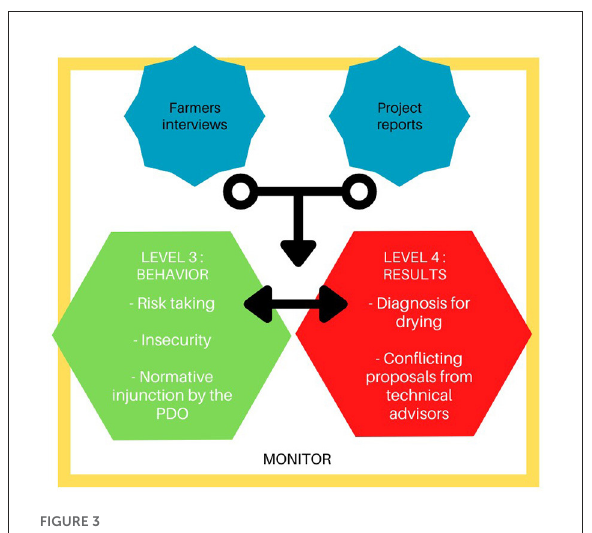
(v2.0.8, Provalis Research, Montreal, Canada). This analysis